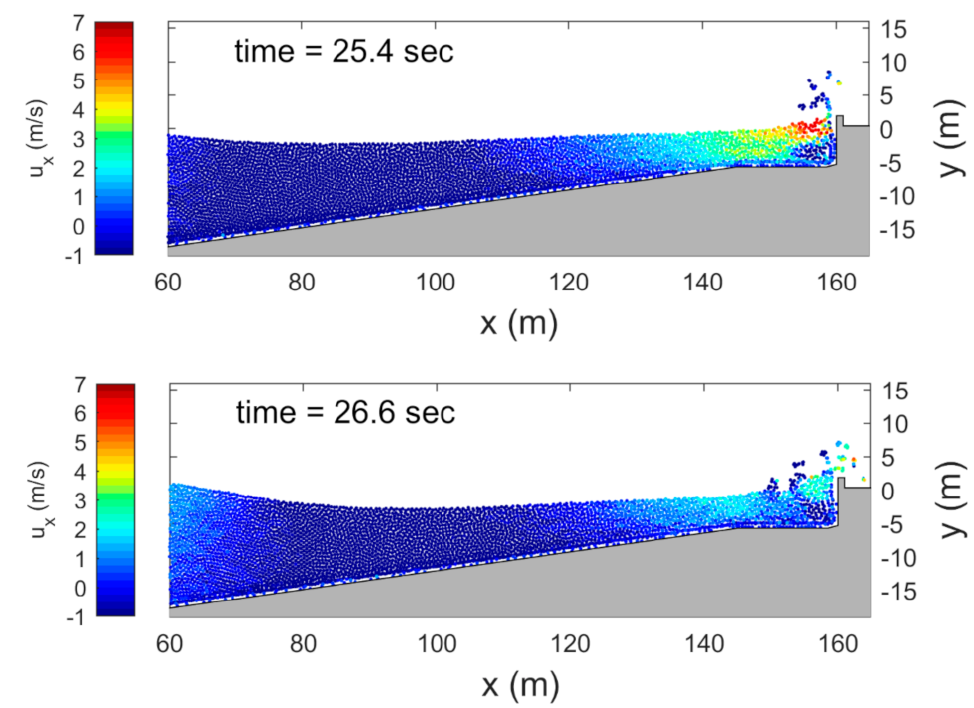
Figure 7. Simulation results without armor blocks (case nA3; H = 4.5 m, T = 12 s).